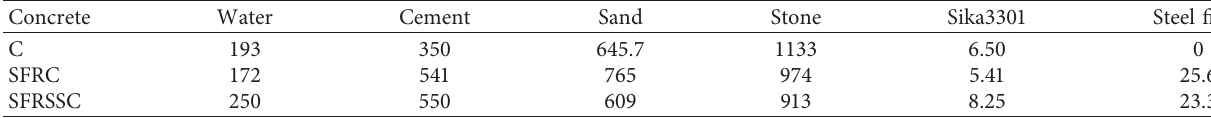
Table 3: Mixture ratios of different kinds of concrete (kg/m 3 ).